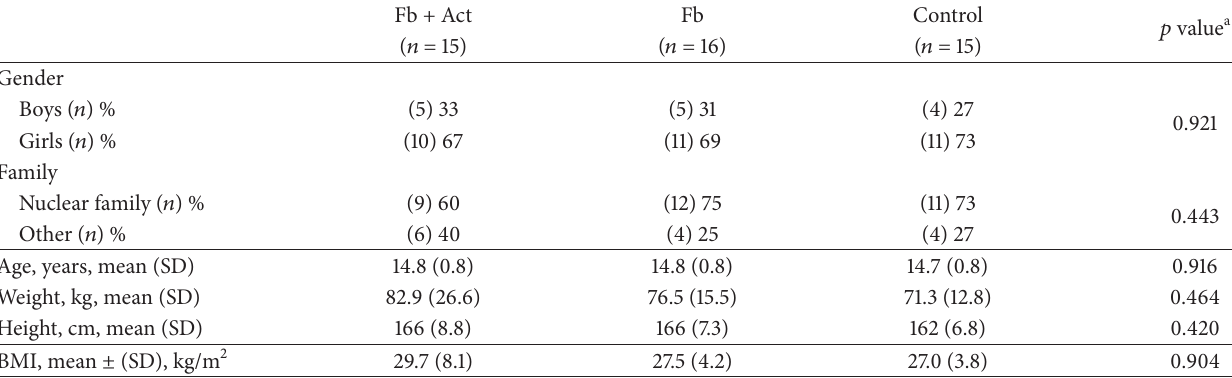
Table 1: Background characteristics of participants in the Facebook-delivered lifestyle counselling + activity monitoring group (Fb + Act), Facebook-delivered lifestyle counselling group (Fb), and control group.